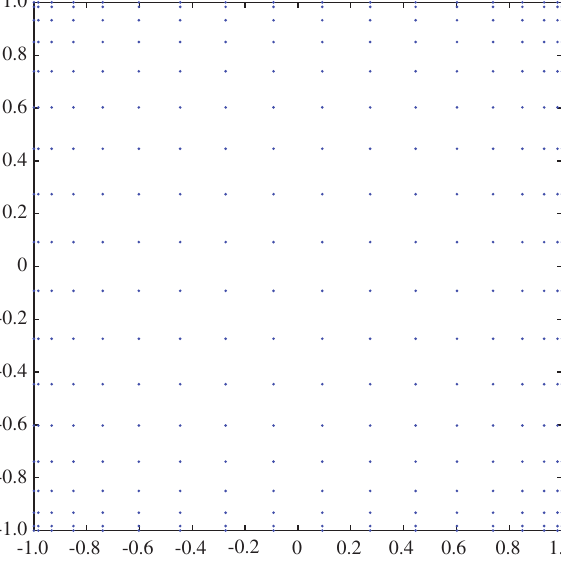
Figure 3 Chebyshev grid with N =